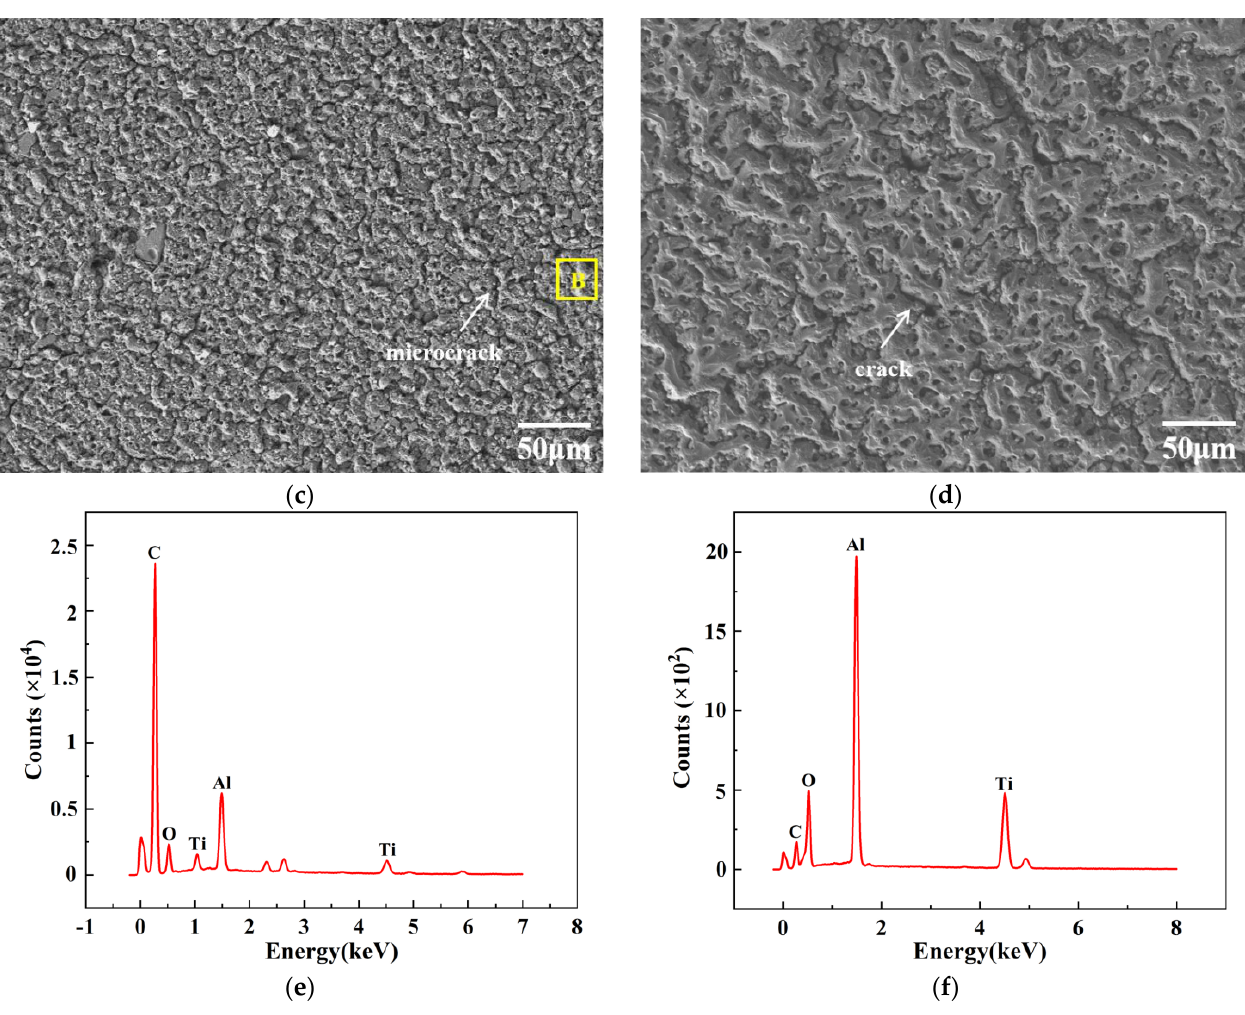
Figure 4. SEM images of Al-20TiC-0.3G composites before and after HCPEB treatment: ( a ) initial sample; ( b ) 5-pulse-treated sample; ( c ) 15-pulse-treated sample; ( d ) 25-pulse-treated sample; ( e ) energy spectrum of point A in original tissue; ( f ) energy spectrum of point B of 15-pulse-treated sample.